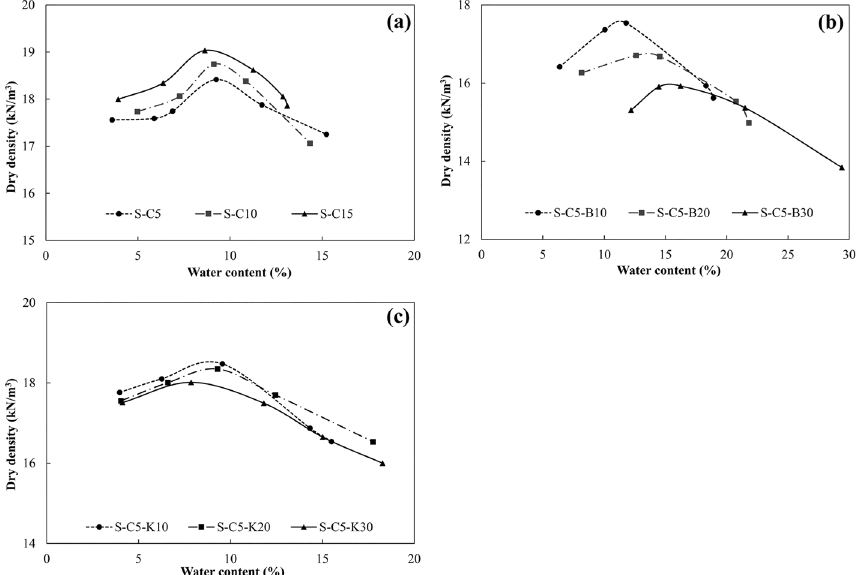
Fig. 4 The dry density-moisture curve of the CSG mixtures: a mixtures with various cement contents and no fine additive, b mixtures containing of 5% cement content in which the base soil containing various bentonite (B) contents: b mixtures containing of 5% cement content in which the base soil containing various kaolinite (K) contents